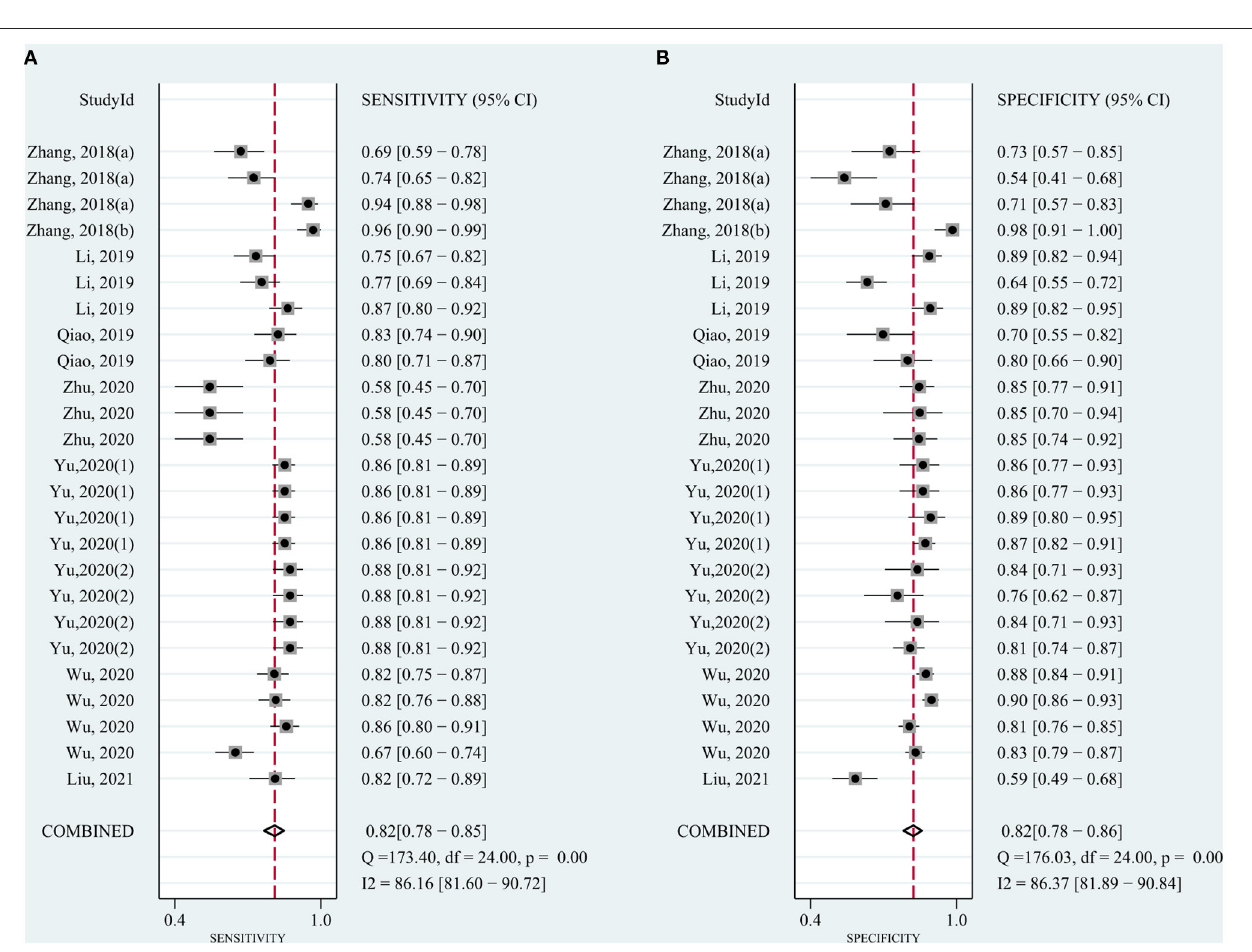
FIGURE 2 | Forest plots for diagnostic accuracy of circRNAs in hepatocellular carcinoma (HCC). (A) Sensitivity. (B)